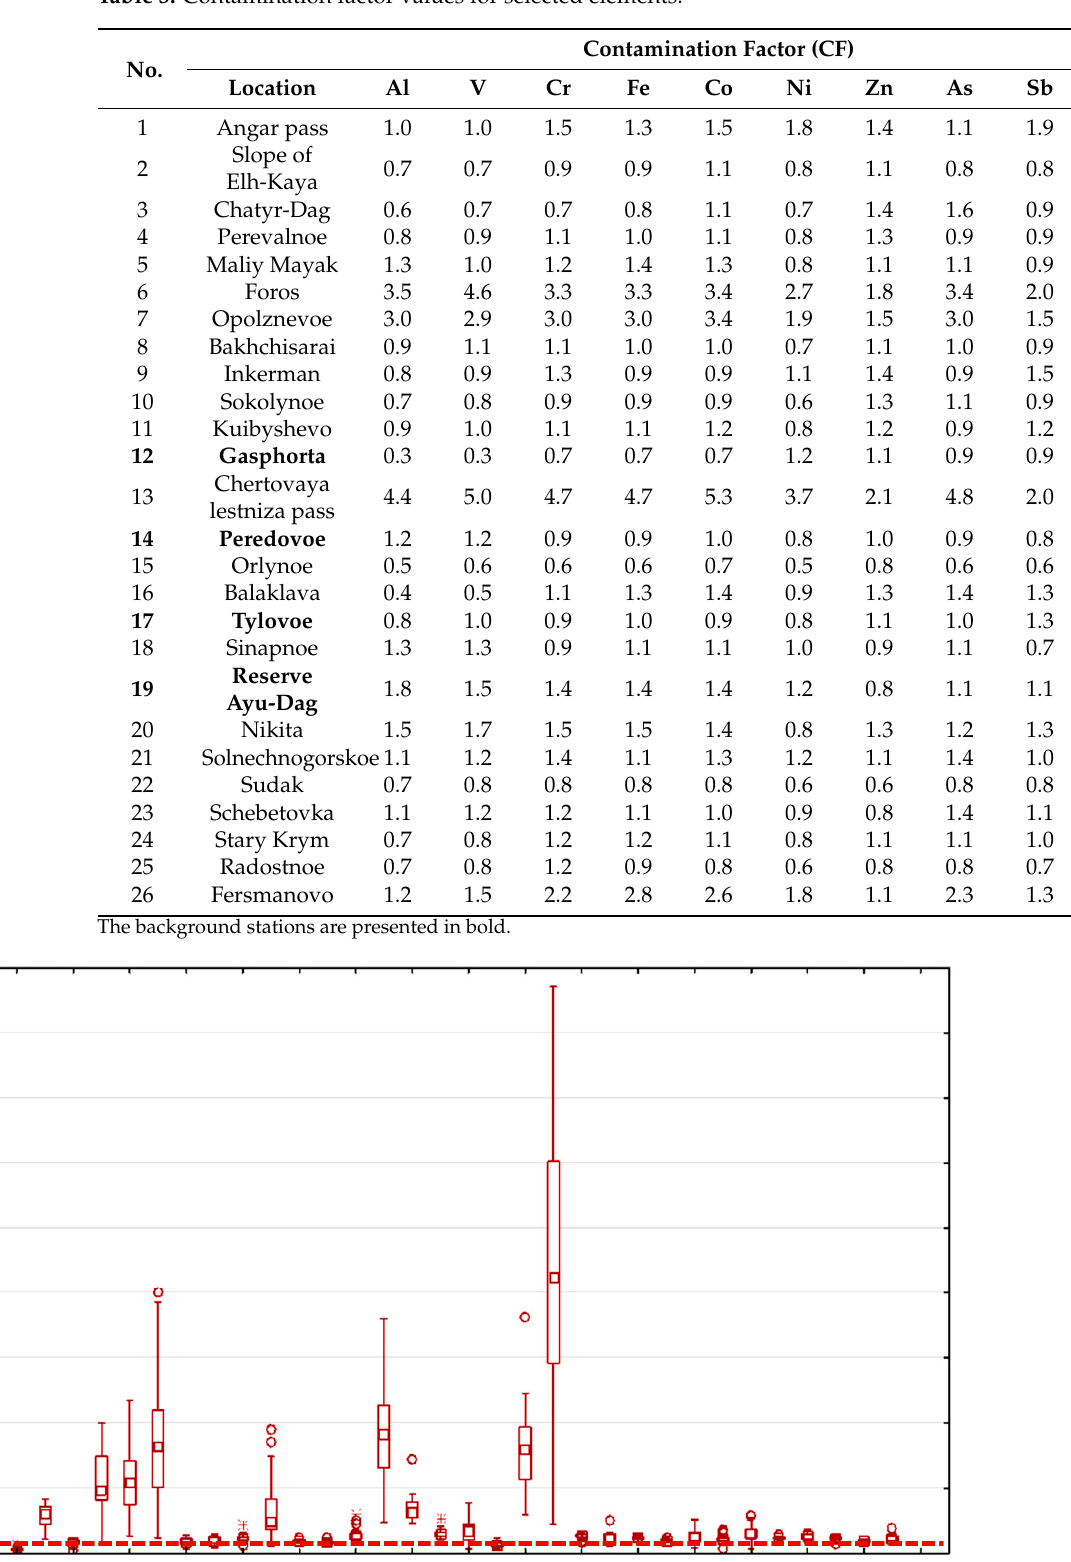
Table 3. Contamination factor values for selected elements.